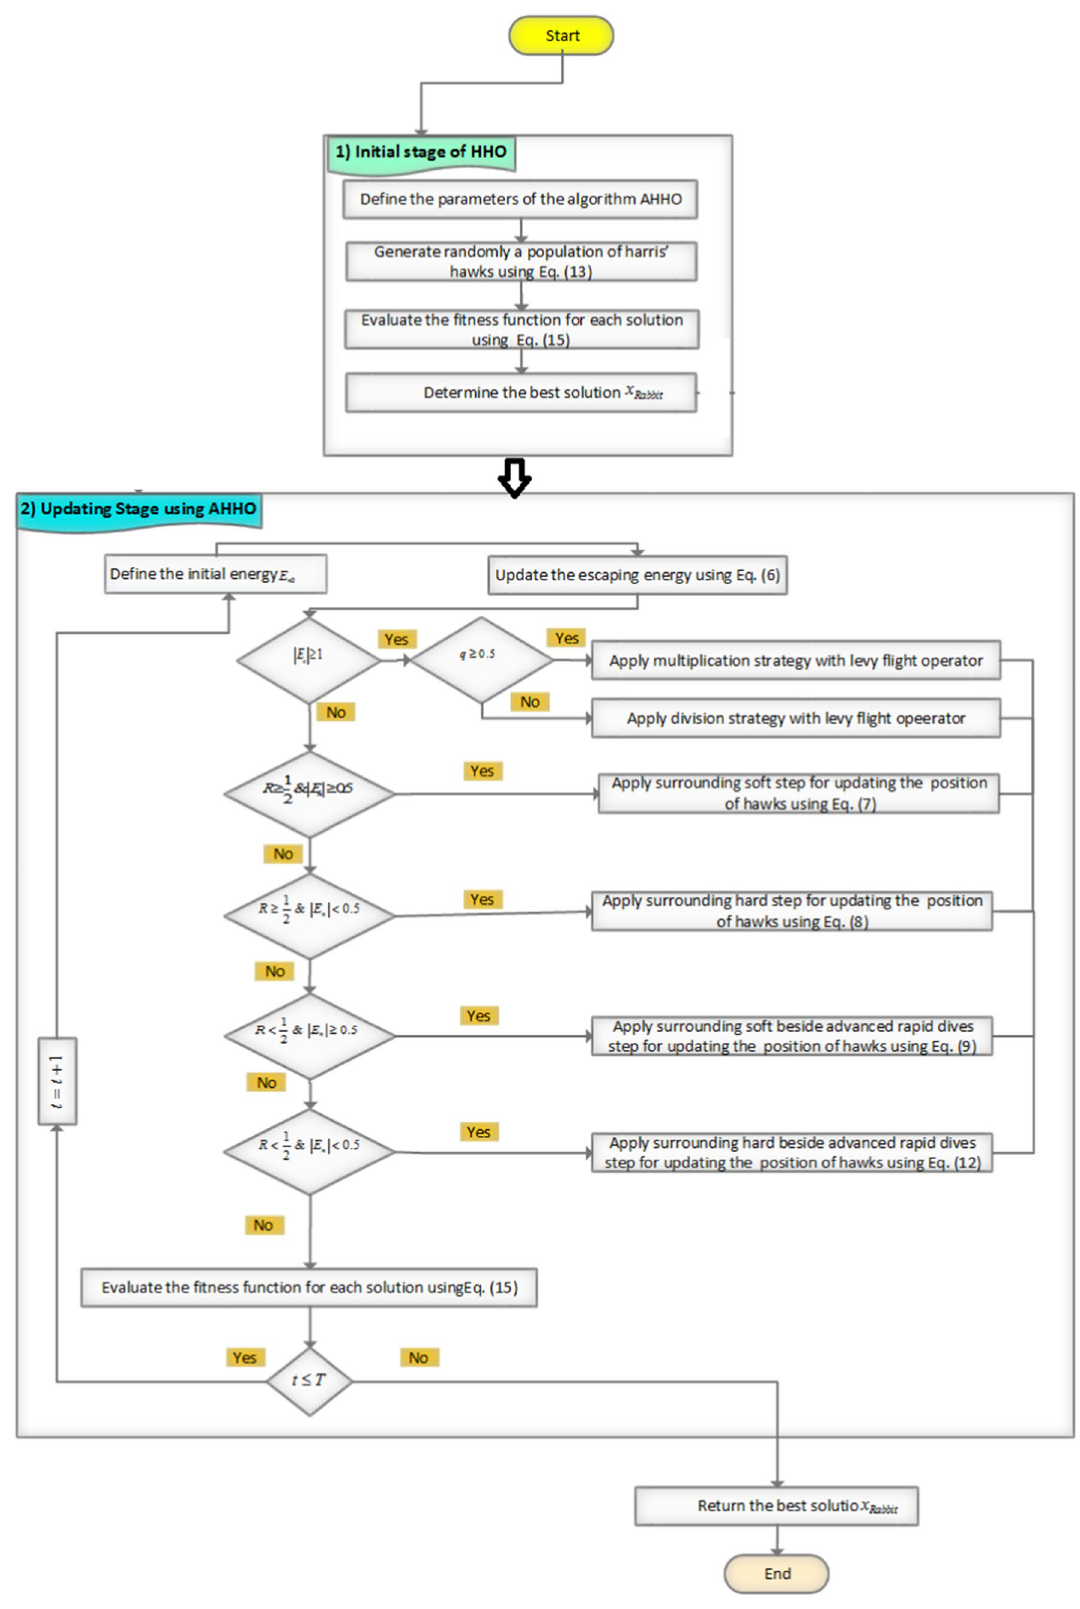
Fig. 2 The flowchart of